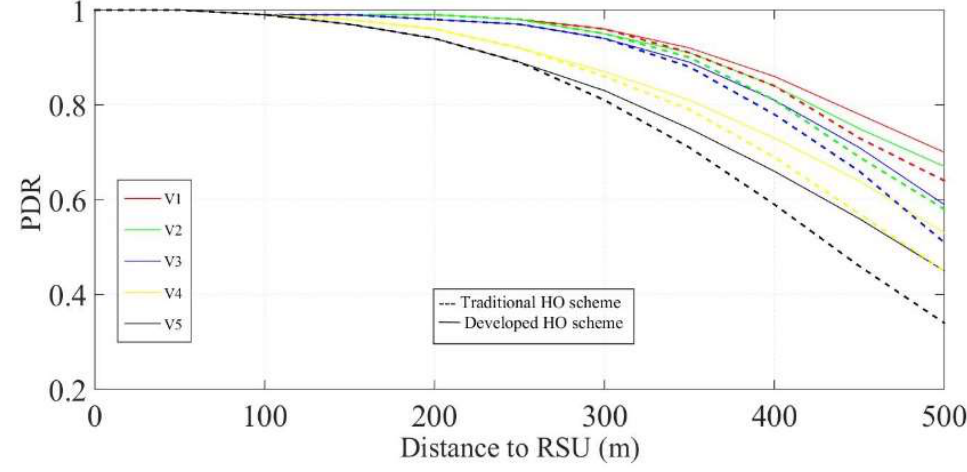
Figure 7. PDR at different vehicle velocities, with the distance to RSU.